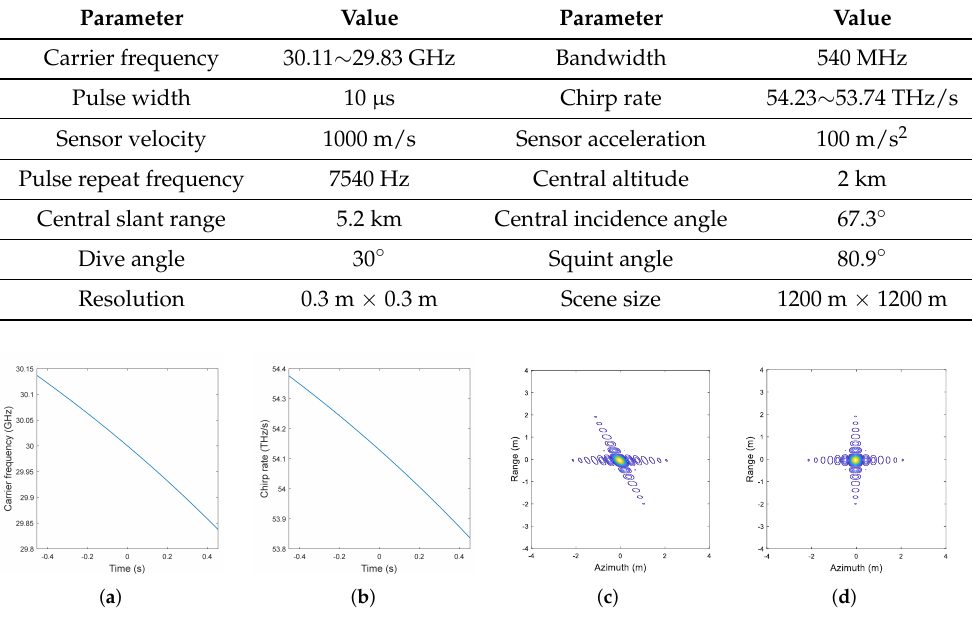
Figure 5. Demonstrations of parameter-adjusting method with ( a ) continuously time-varying carrier frequency, ( b ) continuously time-varying chirp rate, ( c ) PSF with constant parameter and ( d ) PSF with continuously time-varying